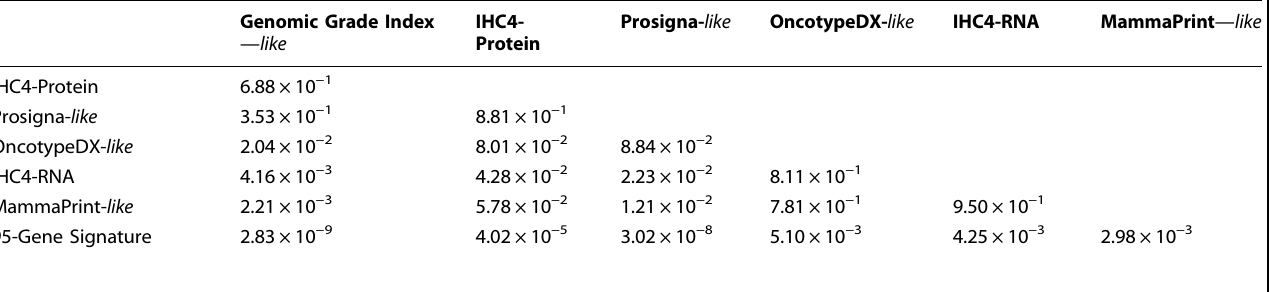
Table 3 Statistical Differences in AUC between multiparametric tests and the 95-gene residual risk signature Genomic Grade Index —